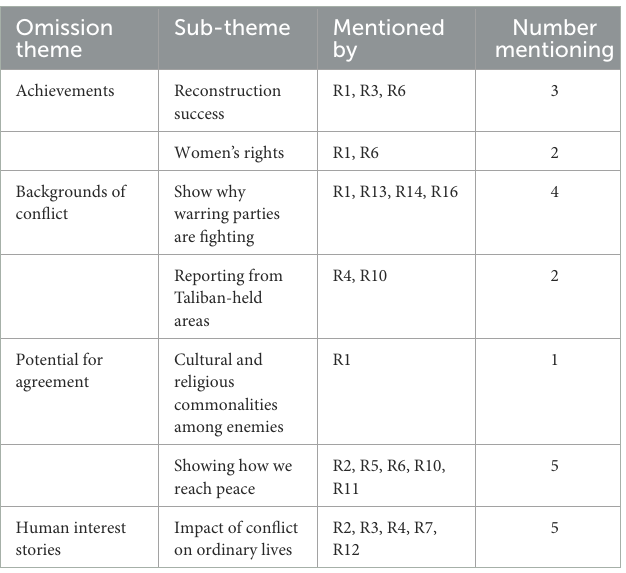
TABLE 3 Omission themes and